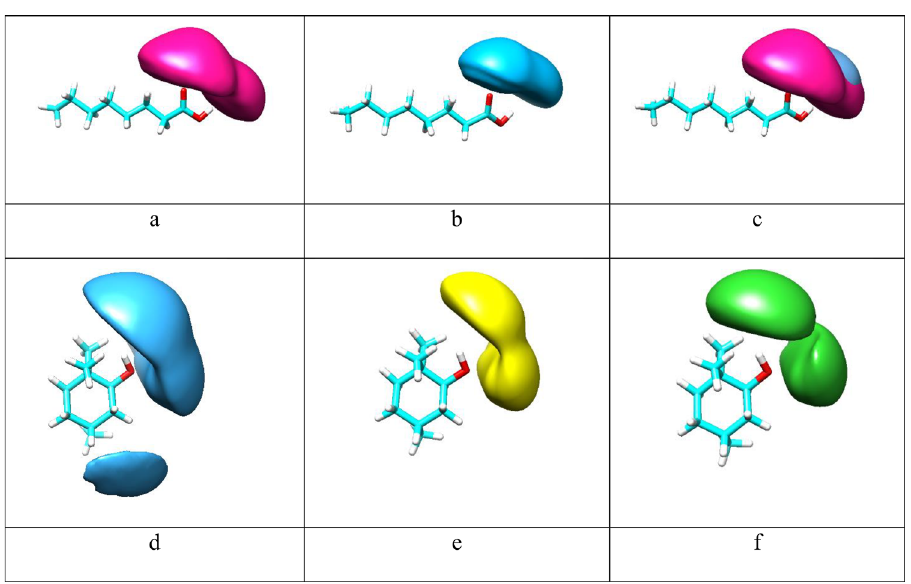
Figure 7. Spatial distribution functions (SDFs) of the binary mixtures with the mole percent of FAs at 70% at 323 K. Green isosurfaces correspond to LUA, yellow isosurfaces correspond to DEC, blue isosurfaces are CAP molecules, pink isosurfaces are MEN molecules. The reference molecules are Caprylic acid ( a – c ), or MEN molecule ( d – f